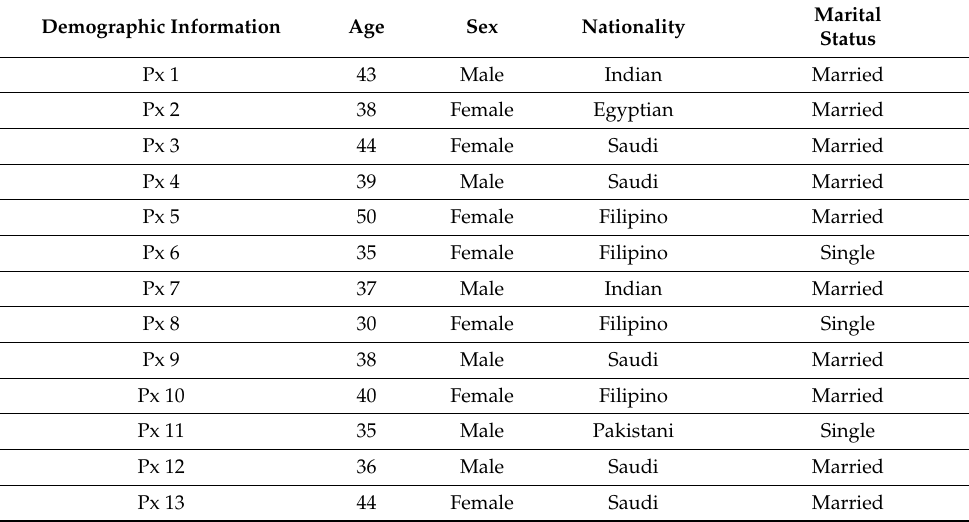
Table 1. Demographic particulars of the